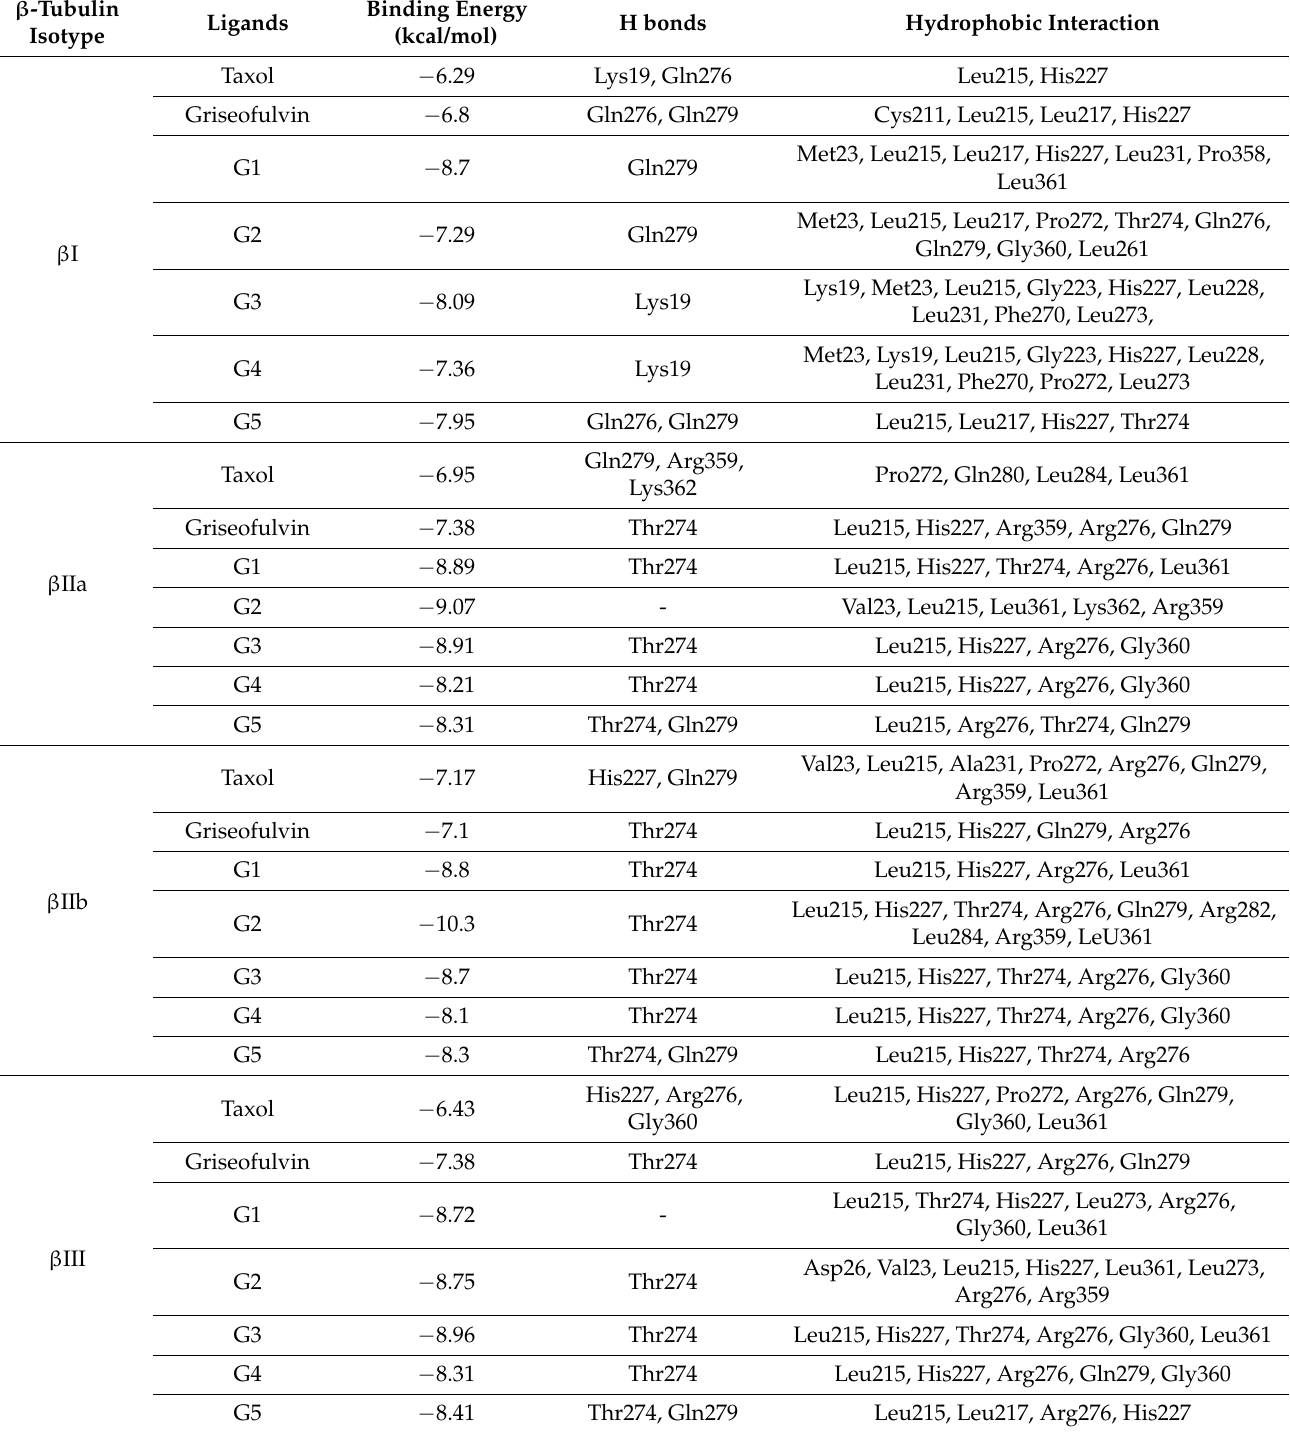
Table 3. Binding energy as well as interactions detail of ligands with different human β -tubulin isotypes after molecular